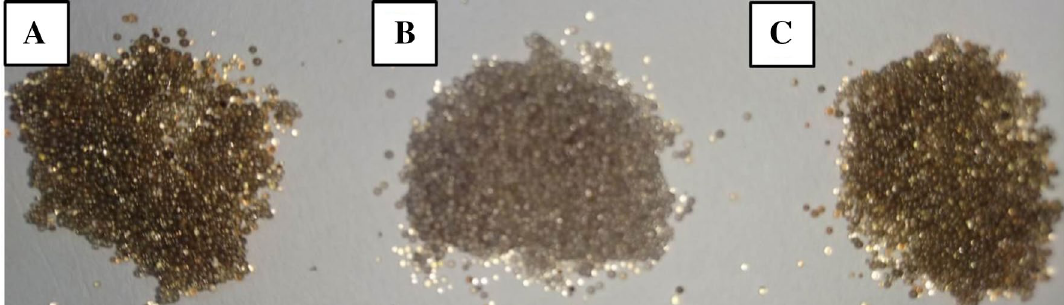
Figure 1. Photos of ( A ) fresh, ( B ) used, ( C ) regenerated resin@P-Ag 2 O